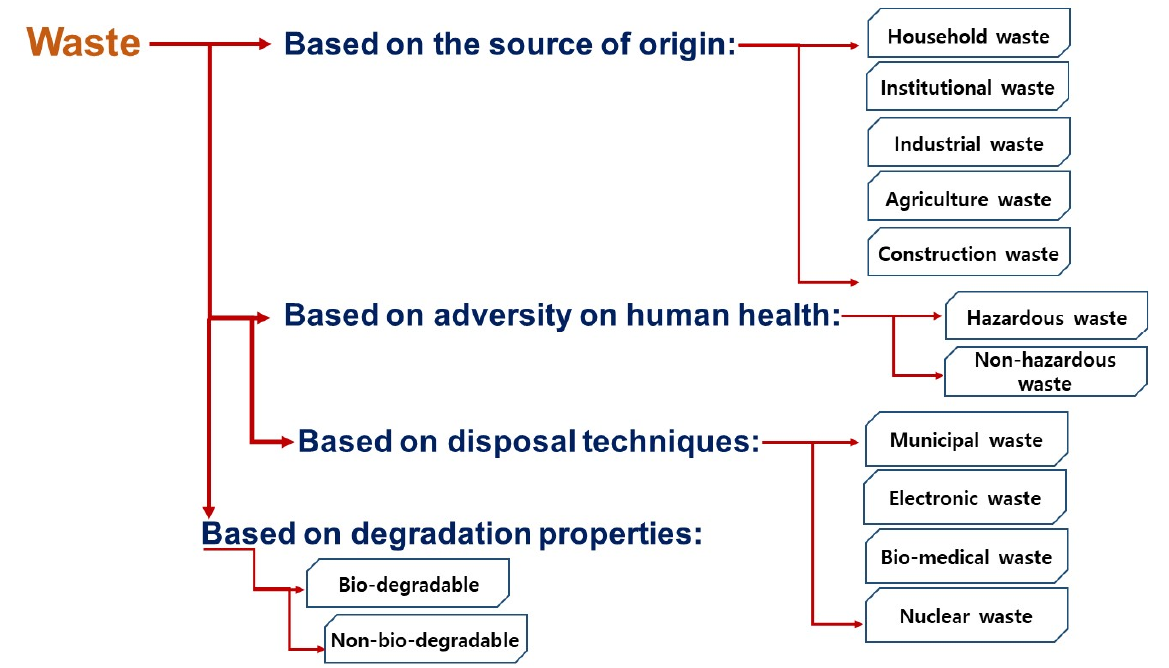
Figure 1. Types of waste based on different categories. Table 1. Types of industrial